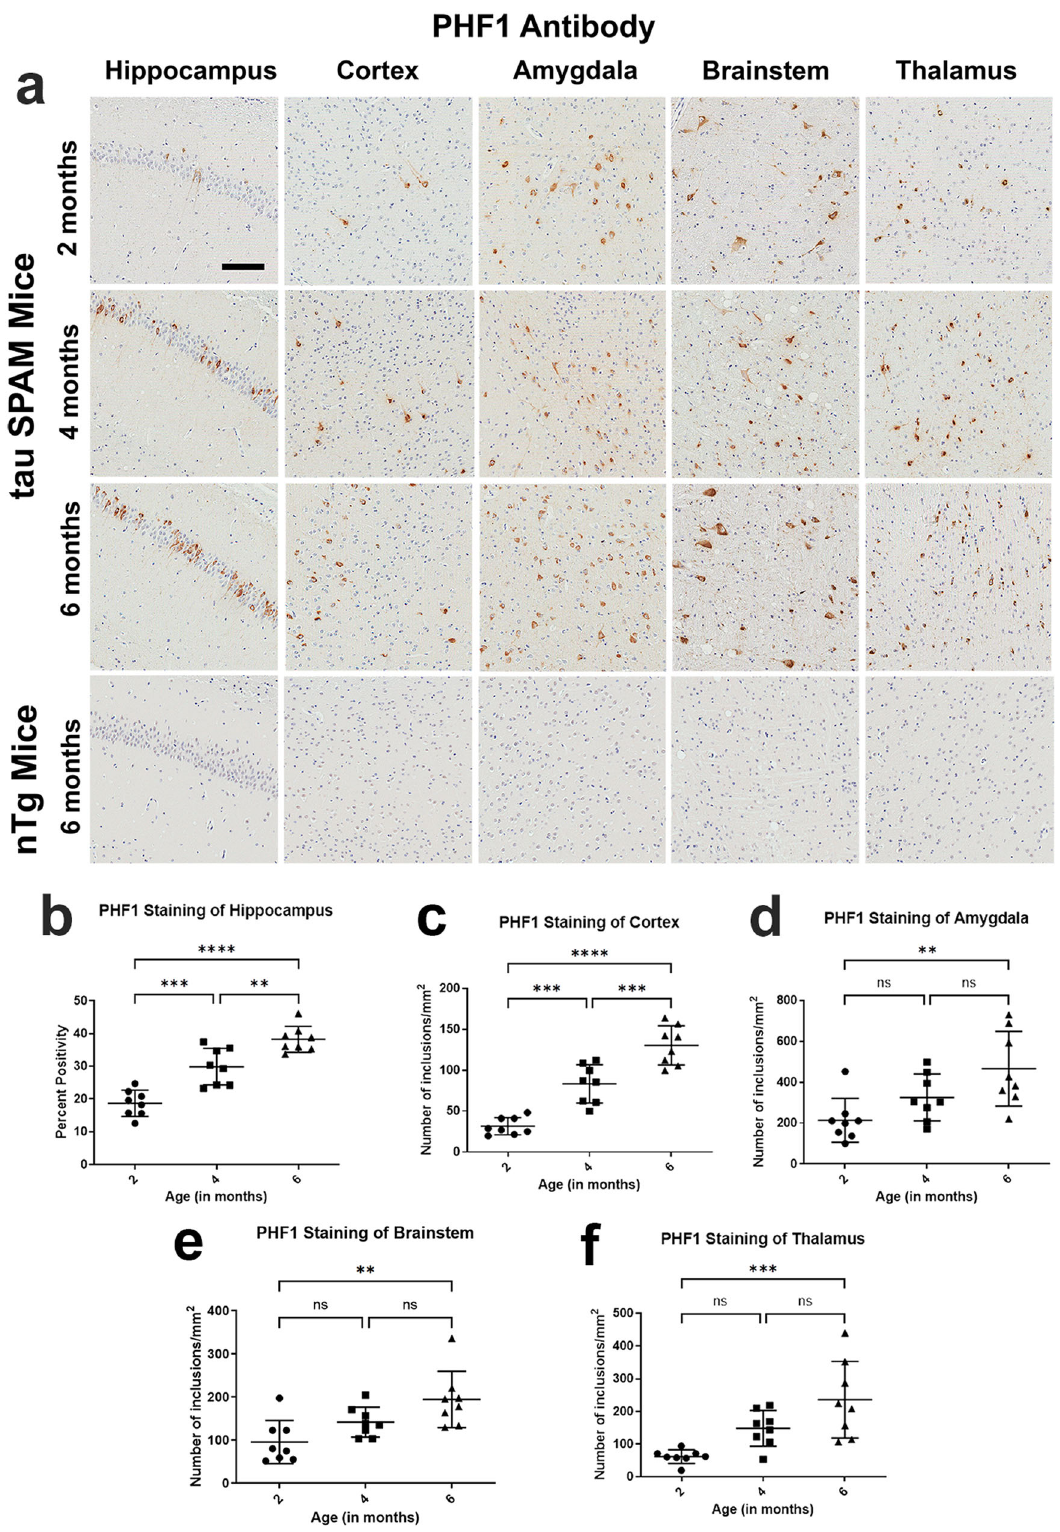
Fig. 4 PHF1-positive phosphorylated tau inclusions progressively increase with age in tau SPAM mice. a Brain samples from tau SPAM mice at ages 2, 4, and 6 months were stained by IHC with PHF1 antibody speci fi c for tau phosphorylated at S396 and S404. Tau inclusions were abundantly found in multiple brain areas as early as 2 months, but further increase with age. Scale bar = 100 μ m. Tau inclusions progressively increased in the ( b ) hippocampus [one-way ANOVA, F (2, 21) = 36.75, p <0.0001], ( c ) cortex [one-way ANOVA, F (2, 21) = 47.72, p <0.0001], ( d ) amygdala [one-way ANOVA, F (2, 21) = 6.641, p = 0.0058], ( e ) brainstem [one-way ANOVA, F (2, 21) = 7.383, p = 0.0037], and ( f ) thalamus [one-way ANOVA, F (2, 21) = 10.60, p = 0.0007] of 2-, 4-, and 6-month-old mice ( N = 8, 4M, 4F for each time point). Pathology was quanti fi ed with Aperio algorithms and compared using one-way ANOVA with Dunnett ’ s test. Error bars represent standard errors of the mean. **** p <0.0001, *** p <0.001, ** p <0.01, ns not statistically signi fi